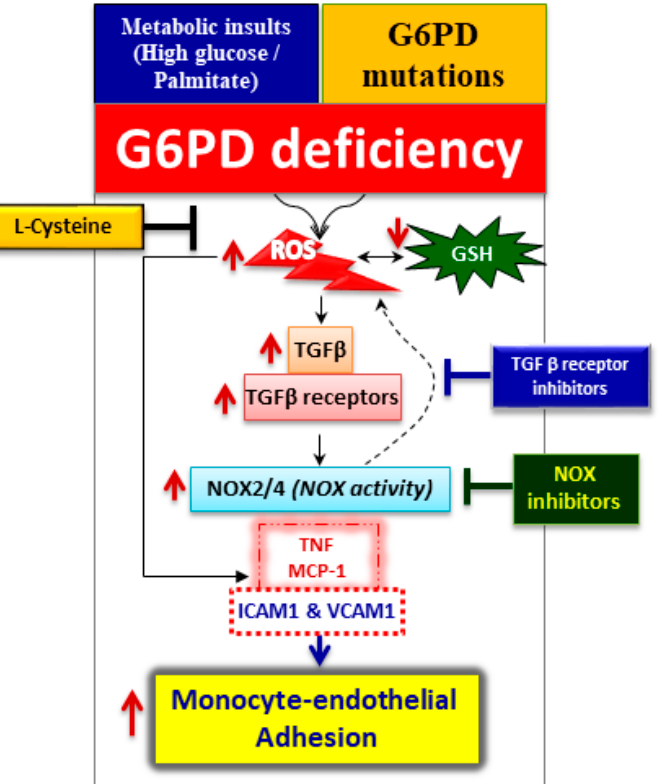
Figure 5. Schematic illustration of the proposed molecular mechanism of glucose-6-phosphate dehydrogenase (G6PD) deficiency in human aortic endothelium and monocytes. Metabolic insults (treatment with high glucose or palmitate) or G6PD gene mutations can cause G6PD deficiency. One possible mechanism is that G6PD deficiency decreases glutathione (GSH) and increases reactive oxygen species (ROS), which may activate transforming growth factor-beta1 (TGF- β 1) signaling and NADPH oxidases (NOX). Activation of these factors generates excess oxidative stress, induces cytokines (TNF and MCP-1), upregulates cell adhesion molecules (ICAM-1 and VCAM-1), and favors monocyte-endothelial cell adhesion. Supplementation with L-cysteine (a GSH precursor) or ablation of the TGF- β signaling complex and NOX by inhibitors abolishes excess oxidative stress and inhibits monocyte-endothelial adhesion in G6PD-deficient cells. The key findings in our study demonstrate that G6PD deficiency plays an essential role in the initiation of a cardiovascular disease event via the TGF- β /NADPH oxidases/ROS signaling pathway.